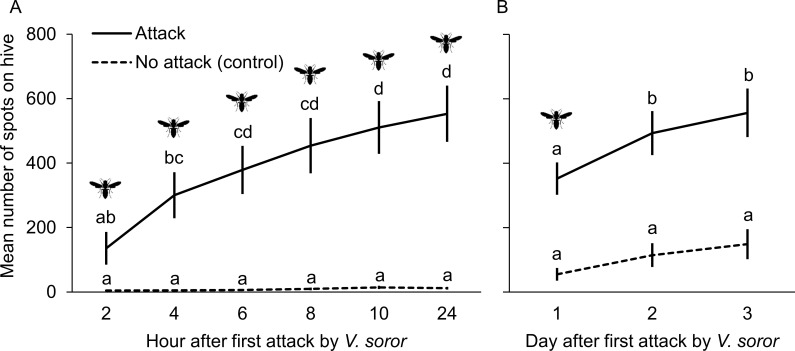
Fecal spotting on hive fronts increased in response to attacks by Vespa soror.In two tests, visits by hornets to attacked colonies occurred naturally over the course of a single day; hornets were prevented from approaching control colonies at all times. Hornet symbols signify treatment and time combinations during which hornets were permitted to attack. (A) Test 1: hive fronts were photographed at two-hour intervals during the day of attack and at the start of the next day to assess changes in spot number. (B) Test 2: hive fronts were photographed at the end of a day of attack and at the end of two subsequent days during which hornet attacks were prevented. Spot counts on hive fronts were estimated from photographs. All colonies were in the same apiary, but different colonies were used for each test. Different letters indicated significant differences in mean (± SEM) spot number across conditions.